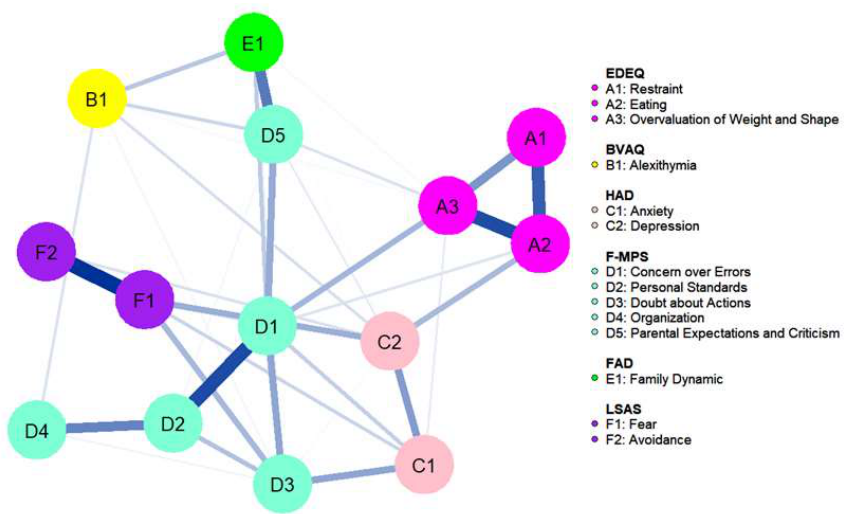
Figure 2. Network plot. Nodes are represented as circles, color coded for each questionnaire (EDEQ: